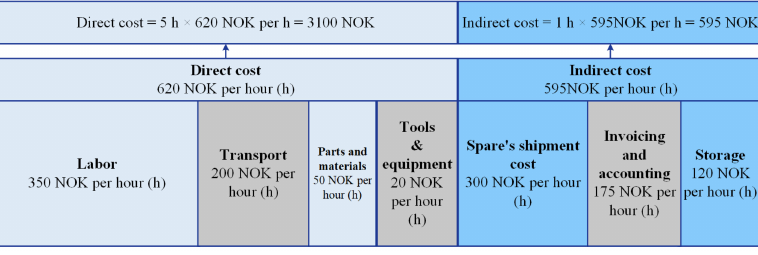
Figure 26. The estimated cost model for each maintenance